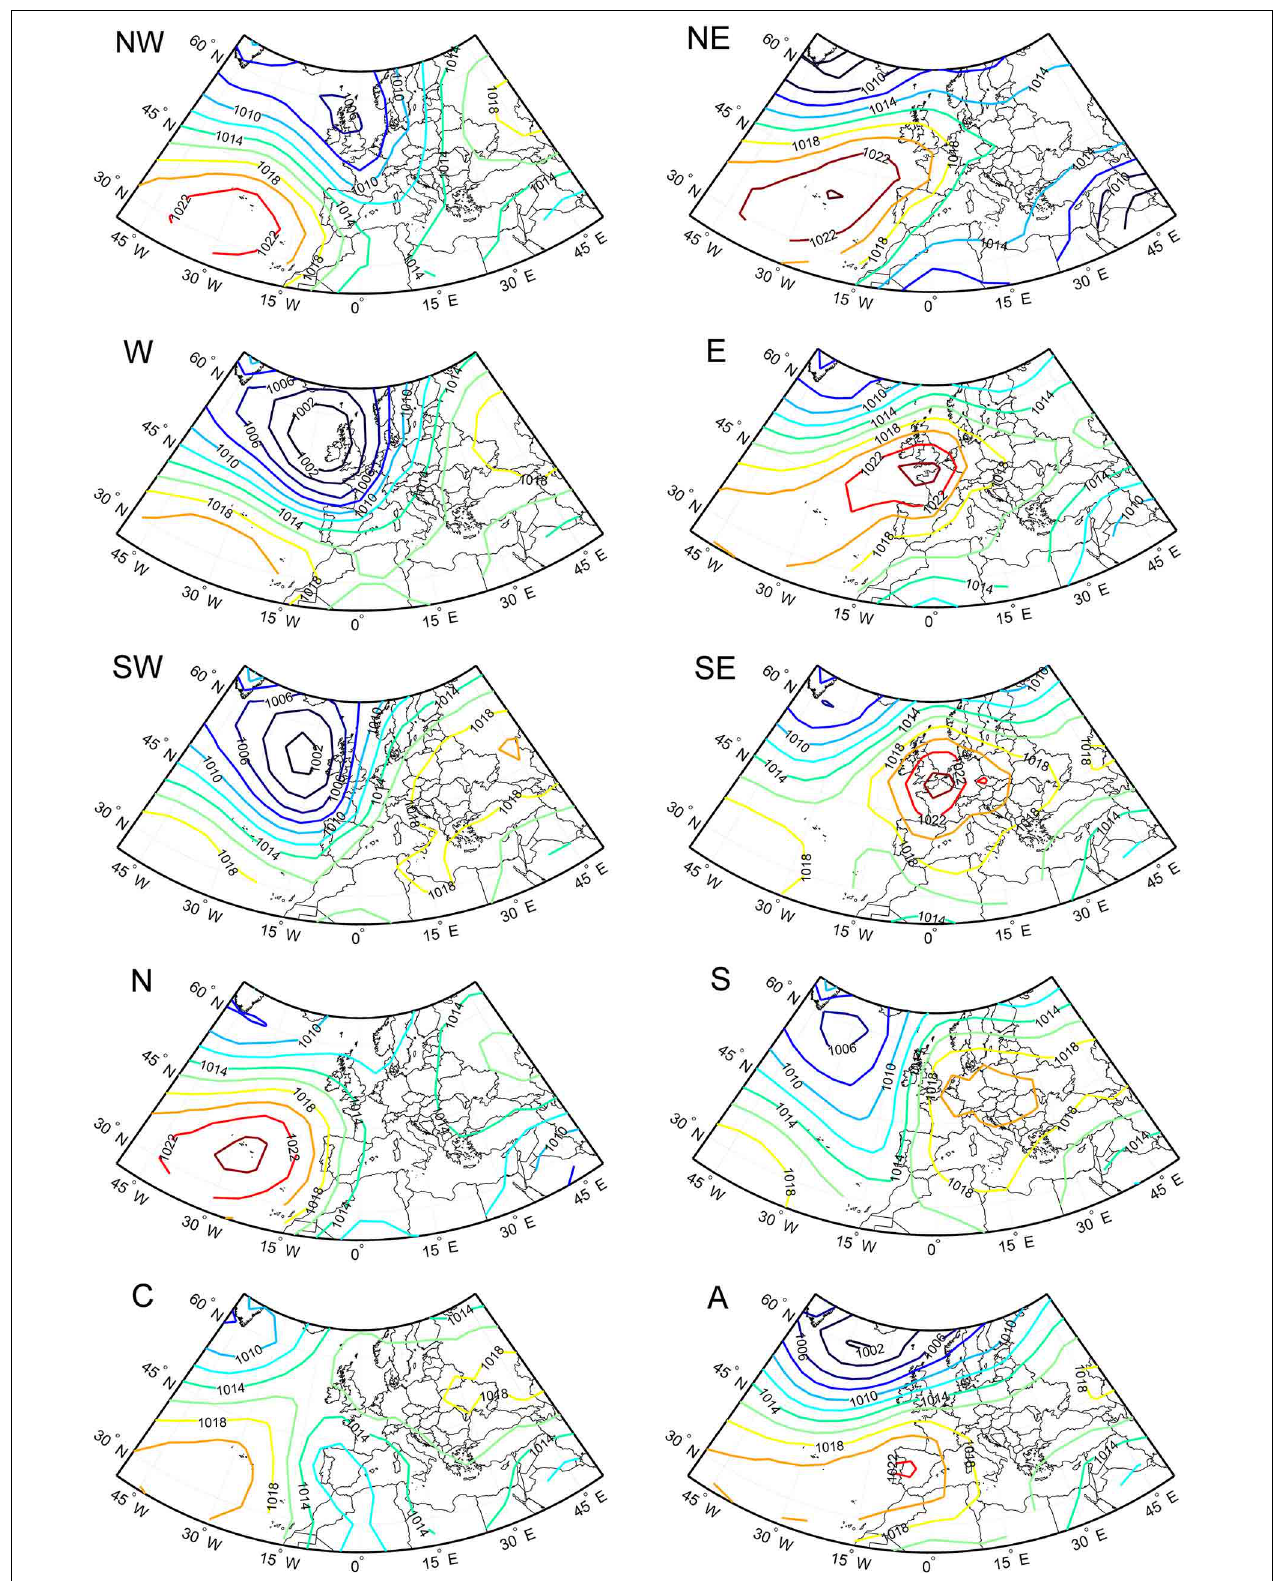
FIGURE 2 | Mean SLP field configuration of the 10 pure WTs for period 1950–2003. The contour interval is 2hPa.